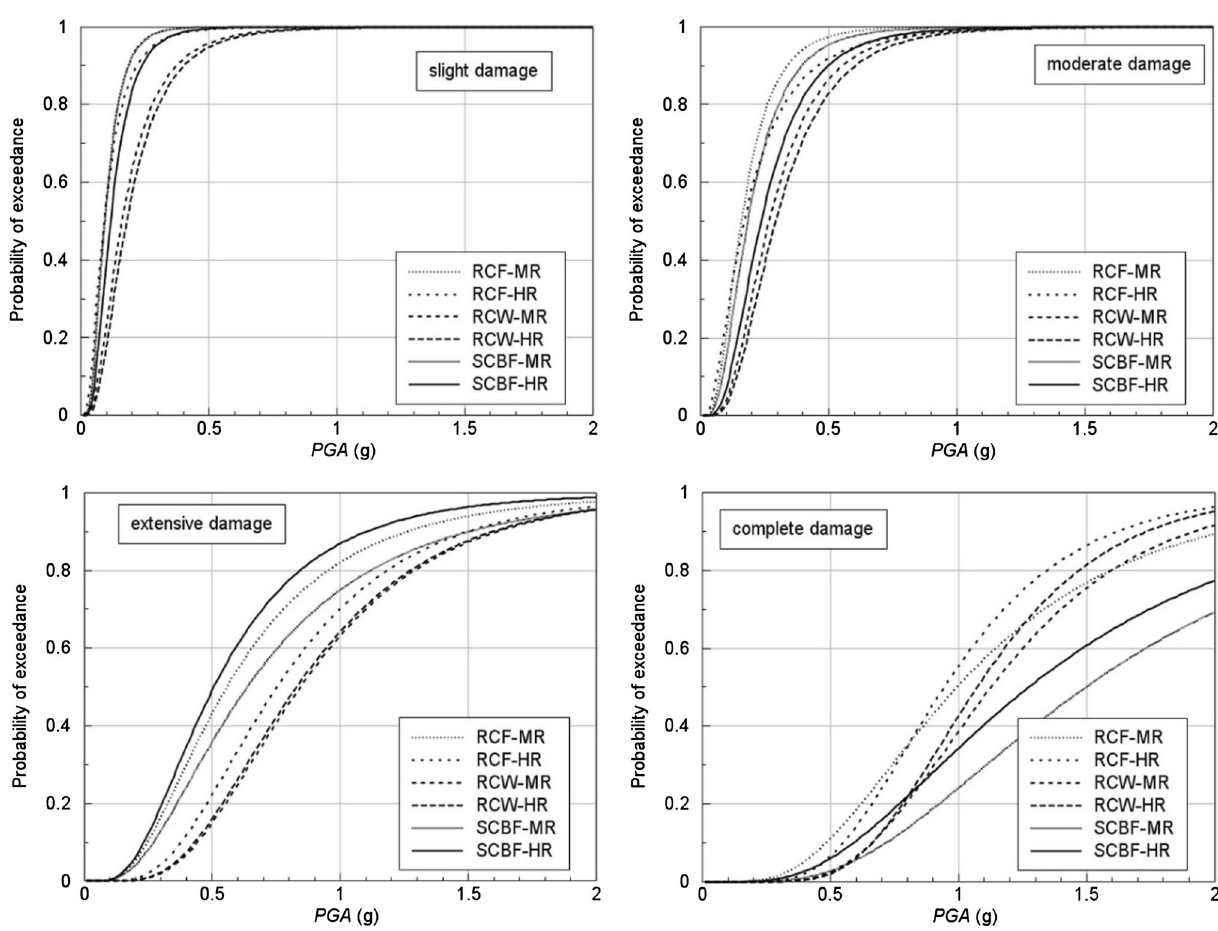
Fig. 10 Fragility curves for four damage states of structures in Bucharest, Romania, obtained for the six generic typologies in terms of